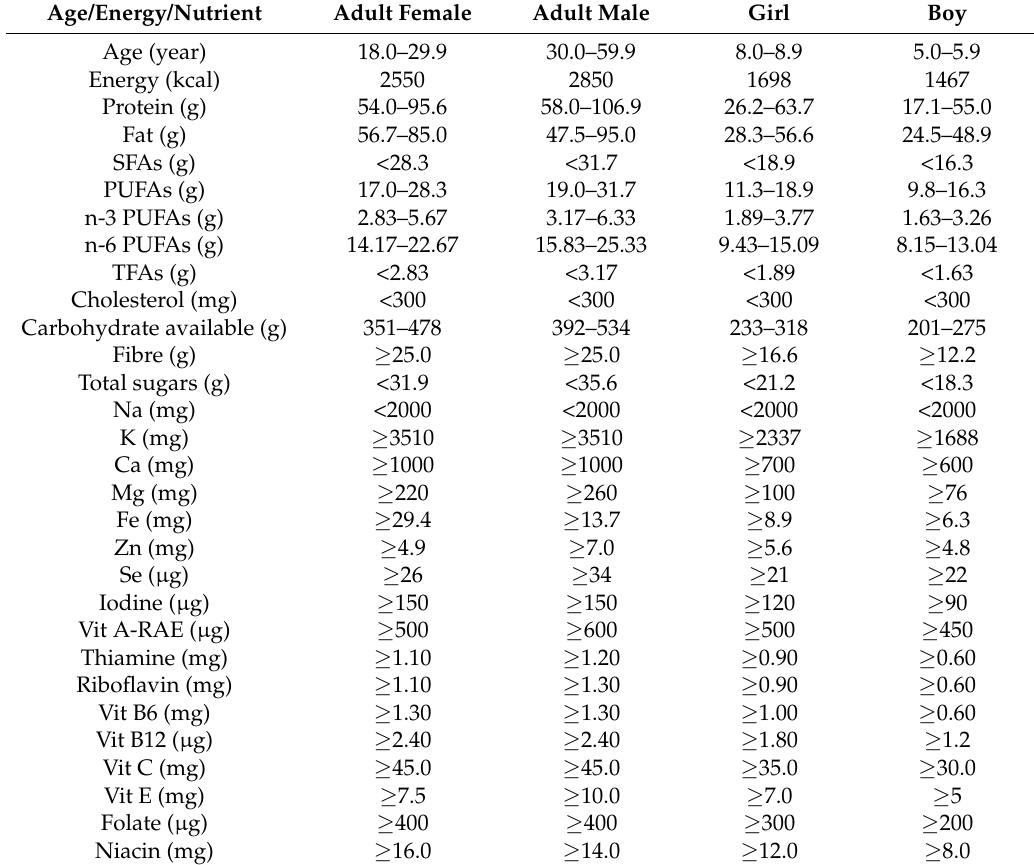
Table 1. Recommended energy intakes (REIs) and recommended nutrient intakes (RNIs) [29,30] applied as constraints for linear optimization of all calculated food baskets. SFAs, saturated fatty acids; n-3 and n-6 PUFAs, omega-3 and omega-6 polyunsaturated fatty acids; TFAs, trans-fatty acids; RAE, retinol activity equivalent. All recommendations refer to one